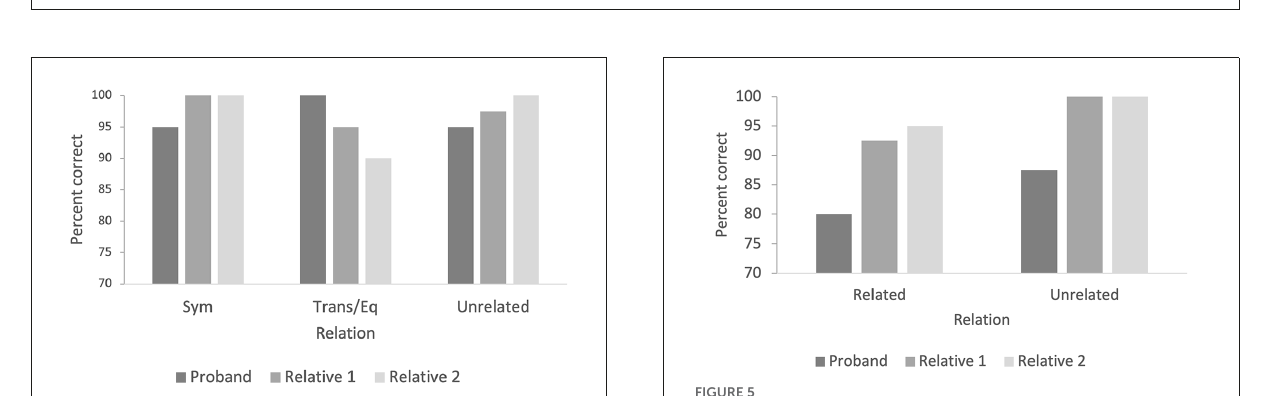
The proband and his unaffected family members